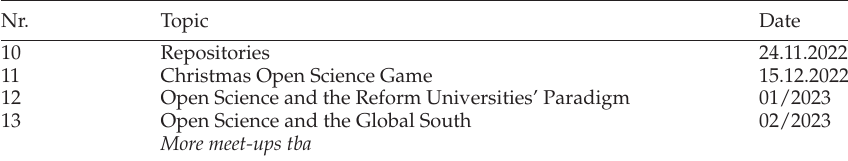
Table 2: List of the Next Open Science Meet-Ups.